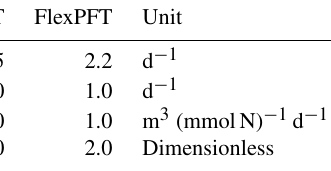
Table 1. Parameters of the InFlexPFT and FlexPFT models Parameter Symbol InFlexPFT FlexPFT Unit Potential maximum growth rate µ max 1.5 2.2 d − 1 Potential maximum uptake rate for N ˆ V 0 1.0 1.0 d − 1 Potential maximum affinity for N ˆ A 0 2.0 1.0 m 3 (mmolN) − 1 d − 1 Chl-specific initial slope of growth α 2.0 2.0